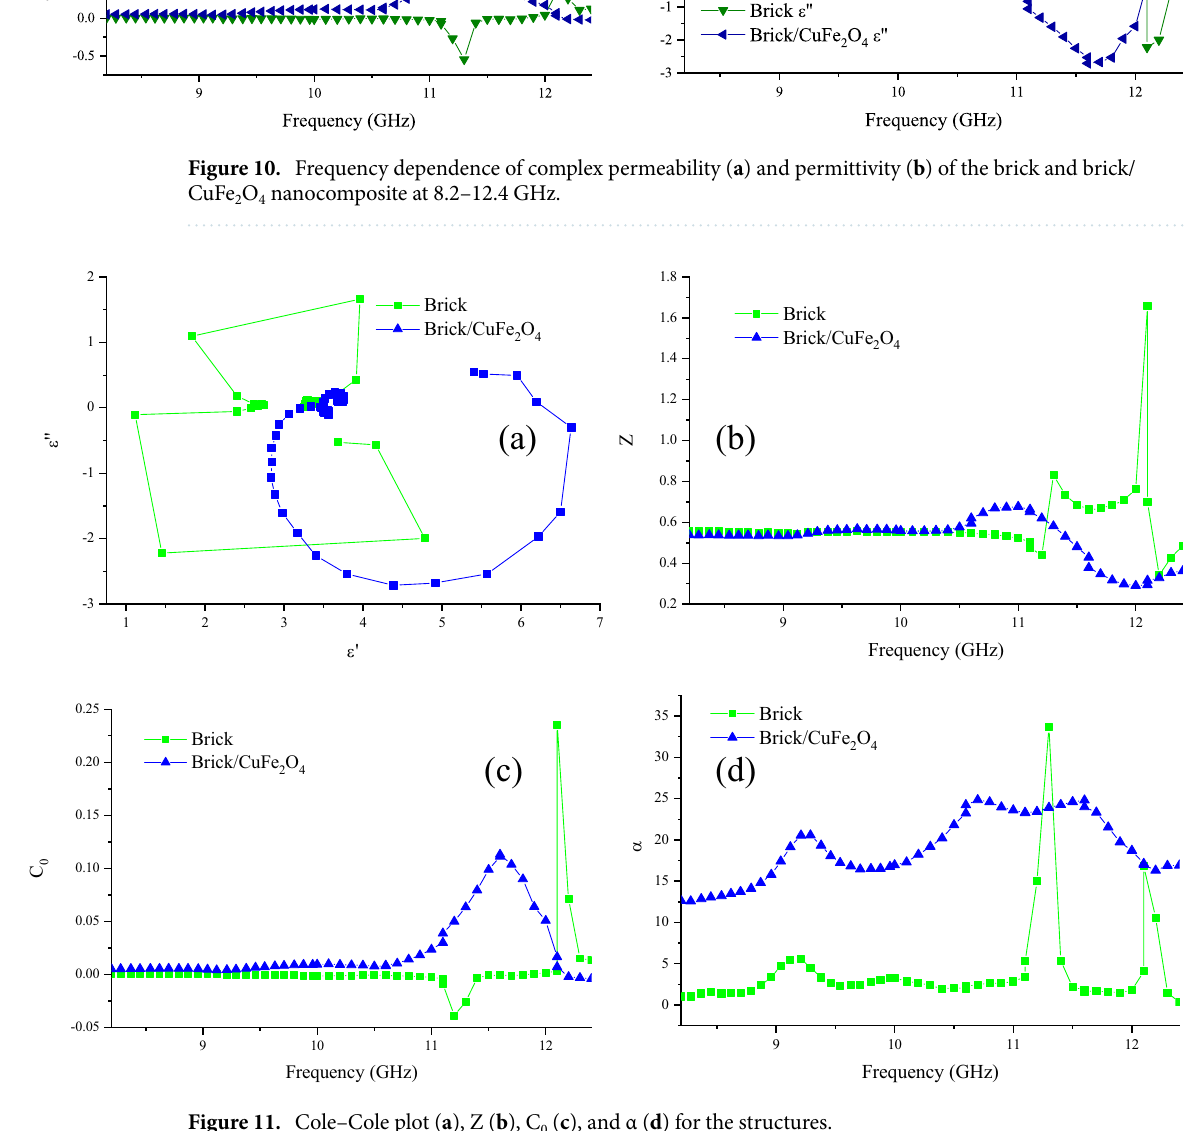
Figure 11. Cole–Cole plot ( a ), Z ( b ), C 0 ( c ), and α ( d ) for the